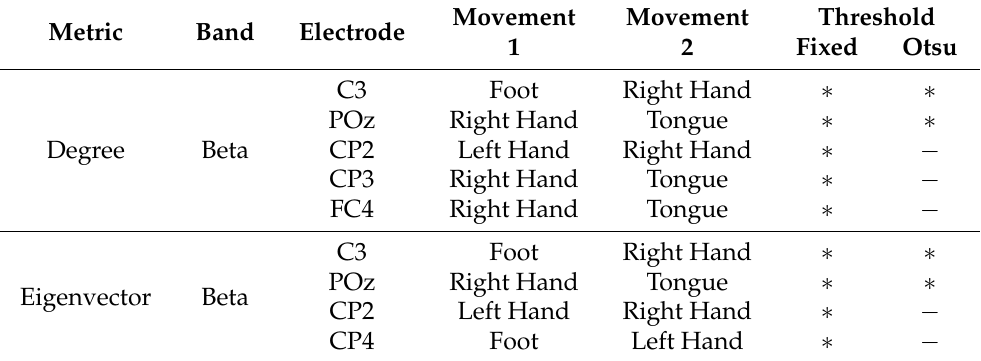
Table 1. p -values < 0.05 for the post hoc Games-Howell test in single layer of the fixed and Otsu’s